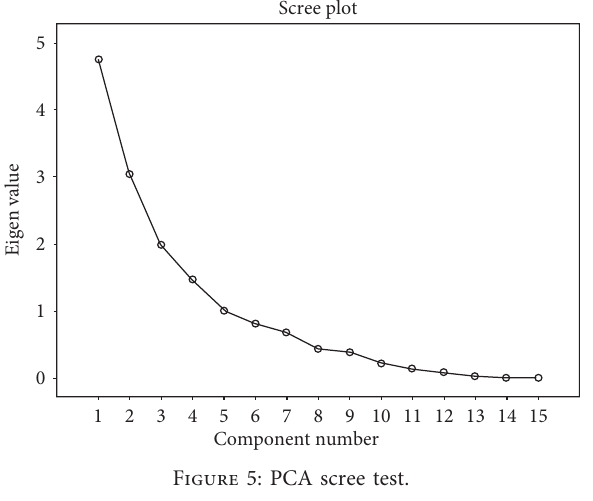
Figure 5: PCA scree test.